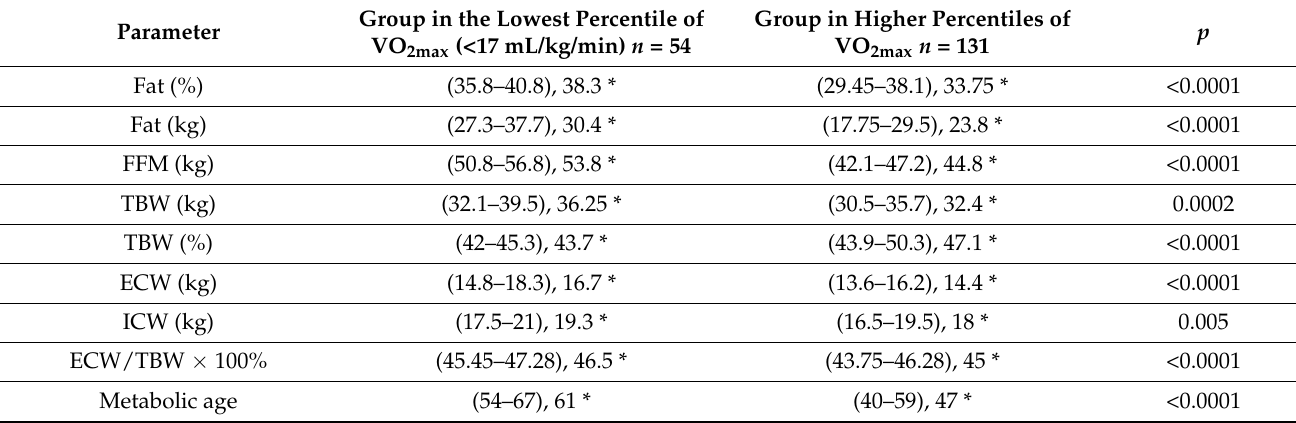
Table 4. Evaluation of body composition parameters.